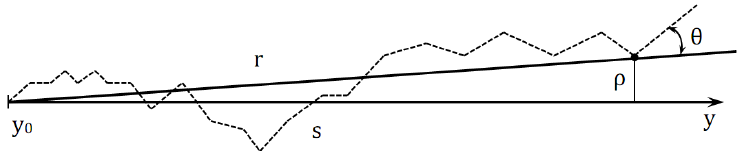
Figure 6. Deviation from the rectilinear trajectories of the motion along straight lines parallel to the y ‐ axis.